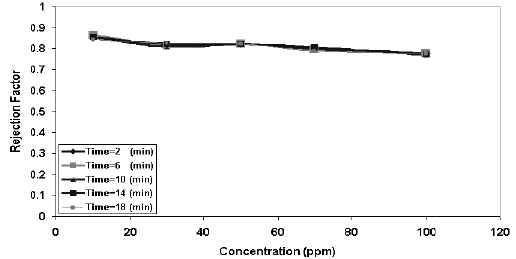
8. The of t flow 4.2.